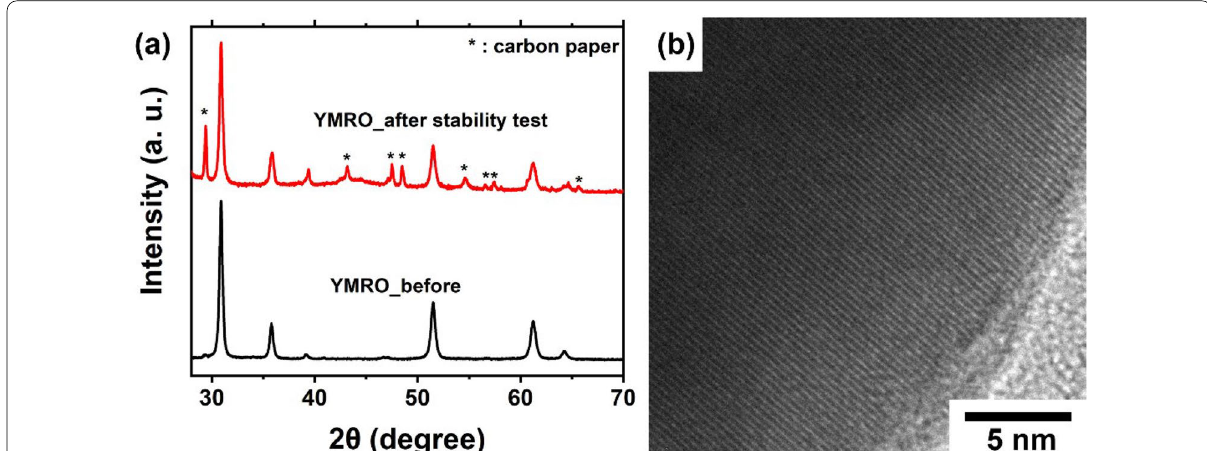
Fig. 3 a XRD pattern and b TEM image of YMRO after the stability tests